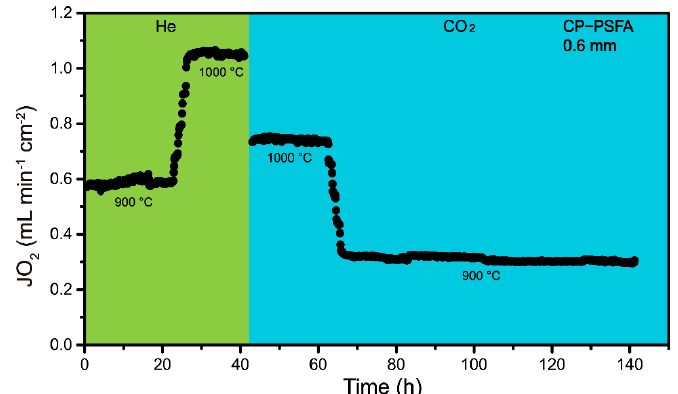
Figure 7. Oxygen permeation fluxes of CPCu-PSFA membrane as a function of time. Condition: 150 mL min − 1 air as the feed gas, 49 mL min − 1 He and CO 2 as the sweep gas, and 1 mL min − 1 Ne as an internal standard gas. Membrane thickness: 0.6 mm.